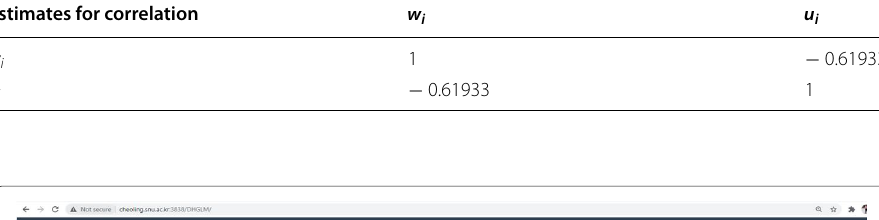
Table 6 Correlation towards crack growth Estimates for